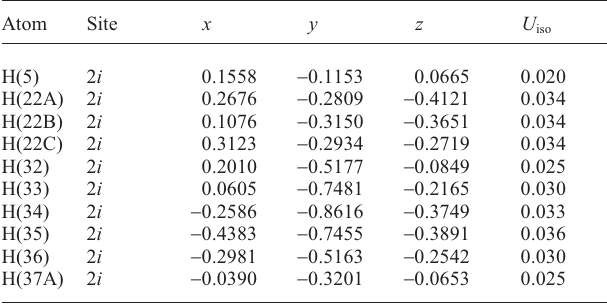
Table 3. Atomic coordinates and displacement parameters (in Å 2 )